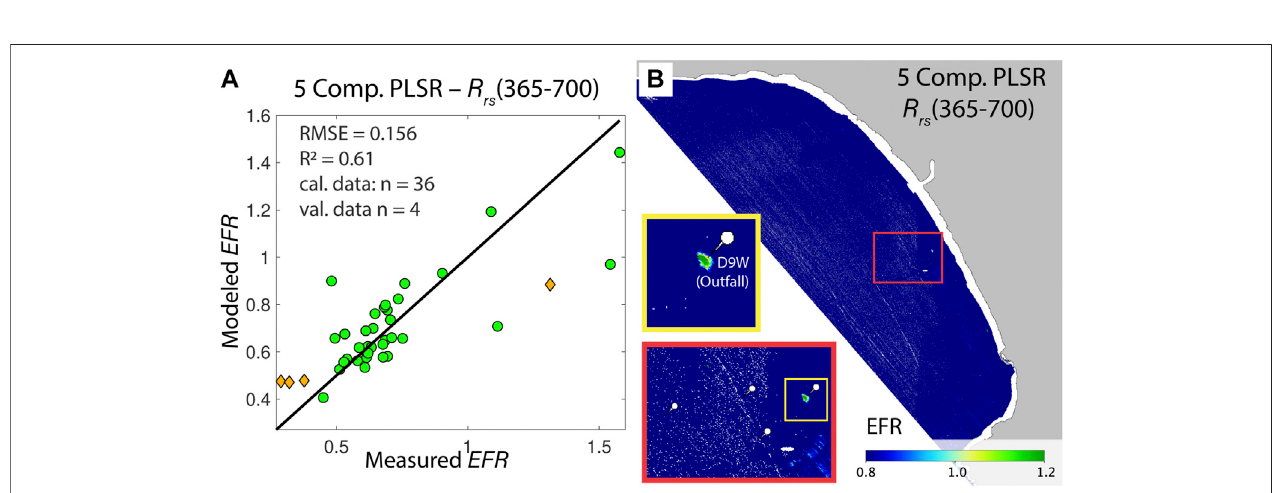
FIGURE 11 | Performance of an empirical PLSR-based algorithm for Ef fl uent Fluorescence Ratio ( EFR ) and its implementation on the PRISM R rs ( λ ) data: (A) EFR valuesmodeledfromthe in-situ measured R rs ( λ ) usingthePLSR-basedalgorithm,versus EFR valuesmeasuredonthesamples ’ fl uorescenceEEMspectra. In-situ data used for calibration ( n (cid:2) 36) are displayed as green circles, and end-to-end validation points comparing measured EFR to inferred EFR from nearest neighbor PRISM pixels ( n (cid:2) 4) are displayed as orange diamonds. (B) Implementation of the PLSR-based algorithm on the PRISM R rs ( λ ) data.